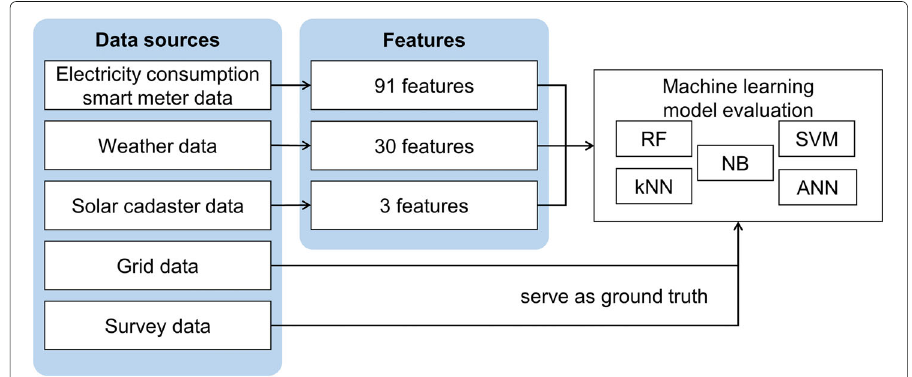
Fig. 1 Data science approach to evaluate heat pump